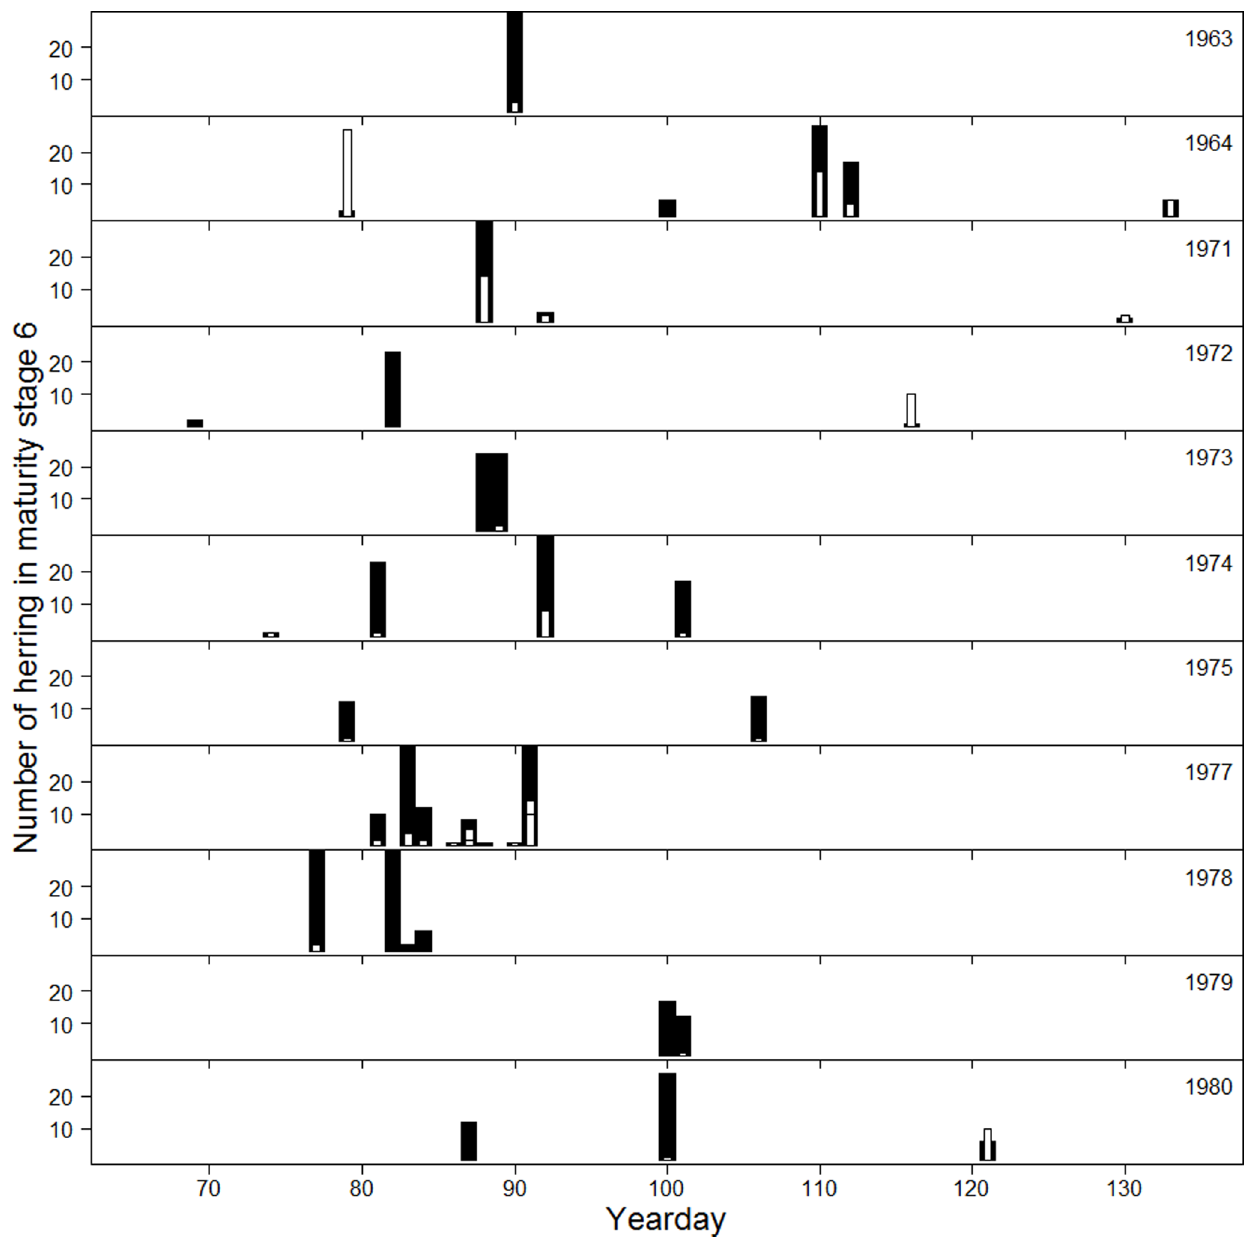
Figure 6. Timing of spawning in fast and slow growers. Number of fast (white) and slow growers (black) in stage 6 (spawning stage) as a function of yearday, all stations in P1 and P2 are included. For the sake of clarity, there is a cut-off on the y-axis at 30